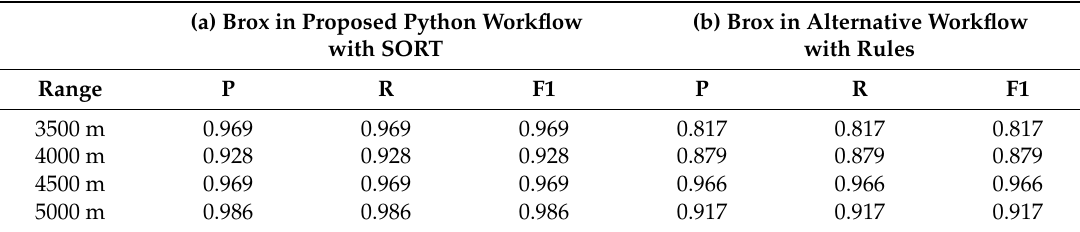
Table 2. Adjusted rules vs. improved python workflow using Brox optical flow in the